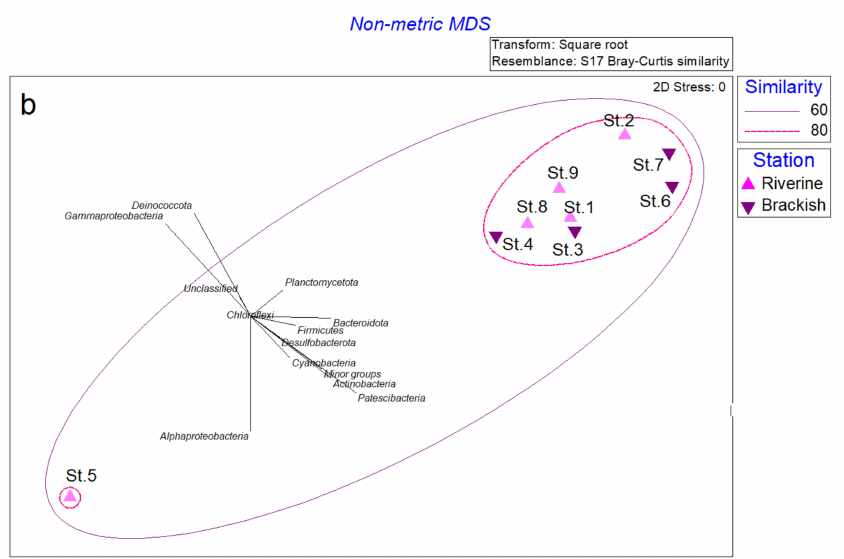
Figure 7. nMDS analysis computed on biological data obtained for the microbial communities from the Pasvik River water at each sampling point in Ice-melt ( − ) ( a ) and Ice-melt (+) ( b ) seasons. Figure 8, referring to abundance data at the phylum level in Ice-melt ( − ) and Ice-melt (+) conditions, showed a clear spatial separation of the samples taken during the two periods; while samples from the Ice-melt (+) period spread to a shorter distance than each other, samples from Ice-melt ( − ) appeared more dislocated and formed a single cluster including brackish St. 3, St. 4, and St. 6. Stations from the Ice-melt (+) season formed three small clusters with a similarity of 80%, organized as follows: Riverine St. 1 and St. 9; brackish St. 4 and St. 6; brackish St. 3, St. 7, and riverine St. 8. A significant difference was highlighted in relative abundance by the ANOSIM test computed by imposing “season” (Ice-melt ( − ) and Ice-melt (+)) as factors (Global R = 0.6; p = 0.001), and the SIMPER analysis attributes this difference mainly to Bacteroidetes and Actinobacteria abundances with cumulative values of 77.6% and 68.7%, respectively.